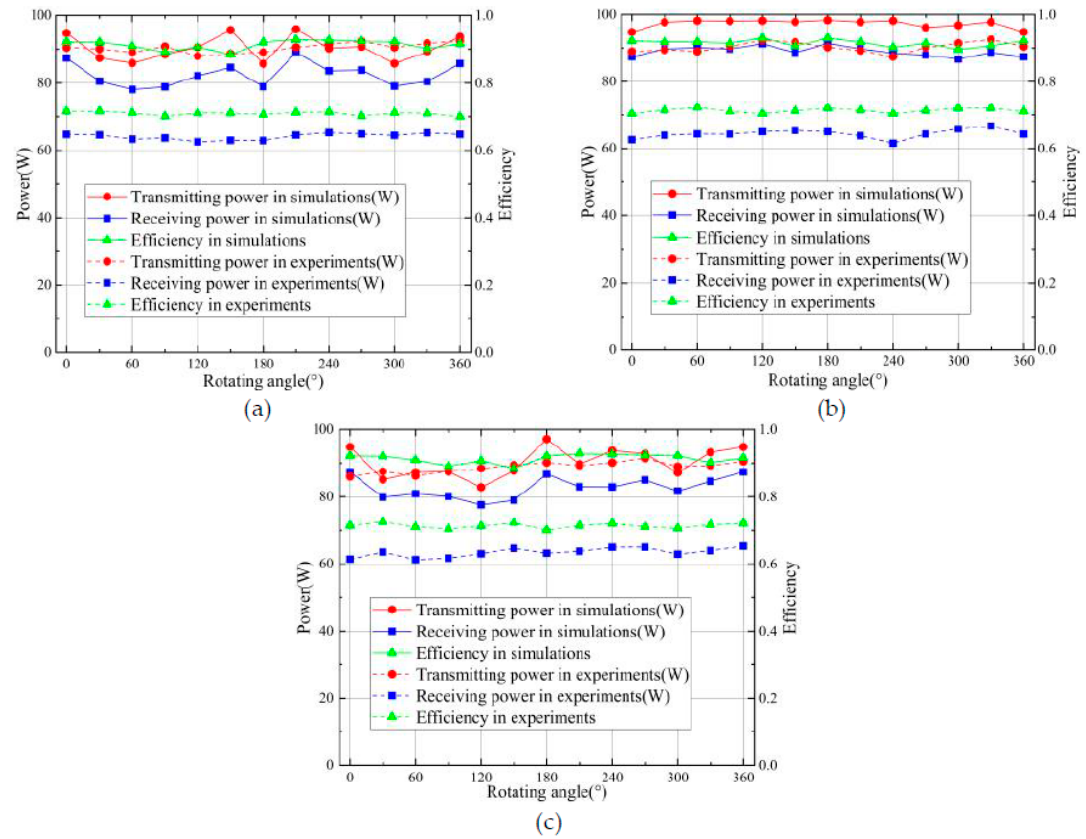
Figure 11. Experimental results of directivity when the ( a ) rotating axis is the x -axis, ( b ) rotating axis is the y -axis and ( c ) rotating axis is the z -axis.